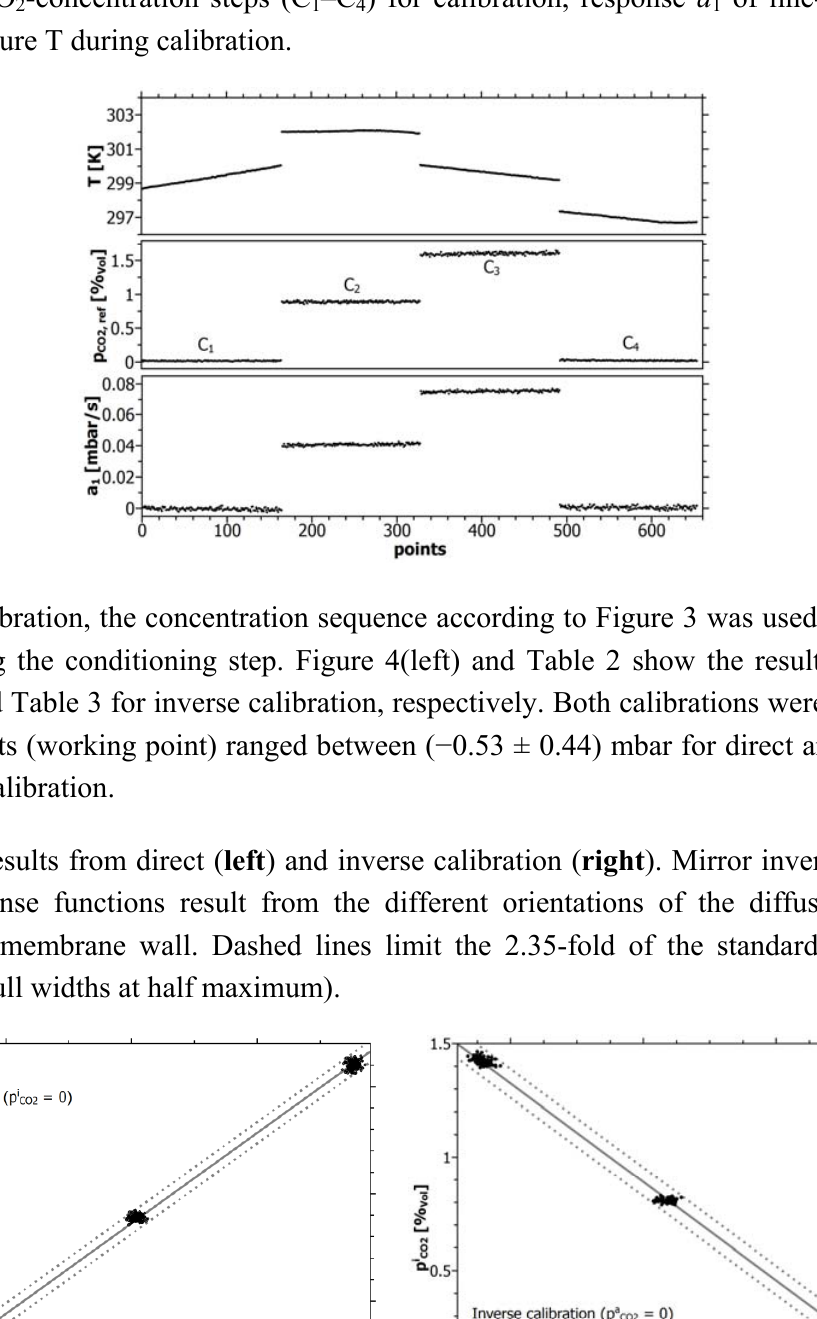
-concentration steps (C 2